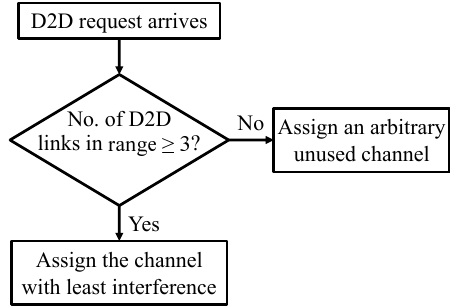
Figure 4. Proposed channel assignment